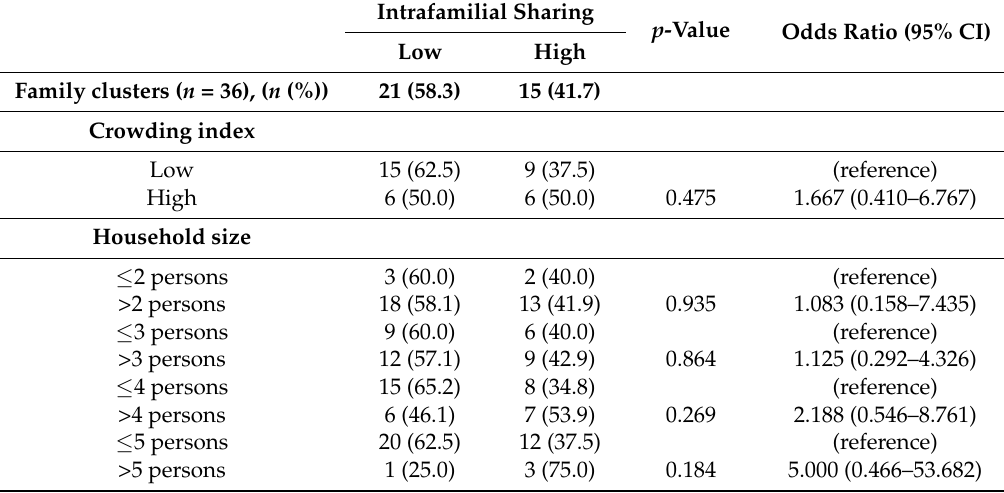
Table 4. Socio-demographic variables and pneumococcal intrafamilial sharing, according to low ( ≤ 50%) and high score (>50%). Intrafamilial Sharing p -Value Odds Ratio (95% CI) Low High Family clusters ( n = 36), ( n (%)) 21